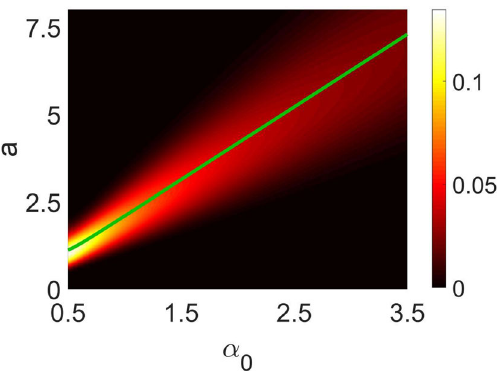
Fig. 32 Variationsinthetransitionprobability.Thehorizontalaxisrep- resents the parameter α 0 , and the vertical axis represents the scale factor a . The different colors represent various transition probabilities, and the green curve represents the average of the scale factor. The parameters are fixed as p a = 1 and V 0 = 50